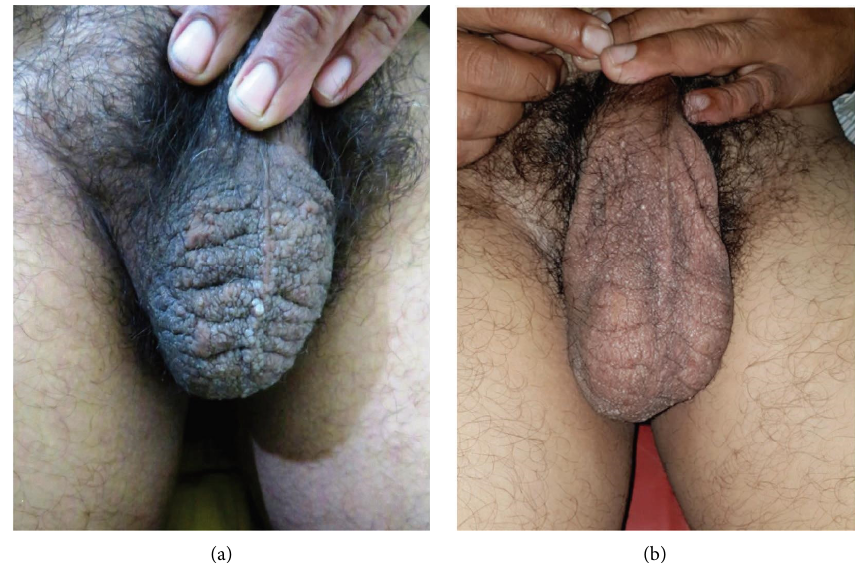
Figure 1: (a) Multiple whitish to skin-colored papules and vesicles on the scrotum with few nodules. (b) Clinical picture of the scrotum after 30 months of